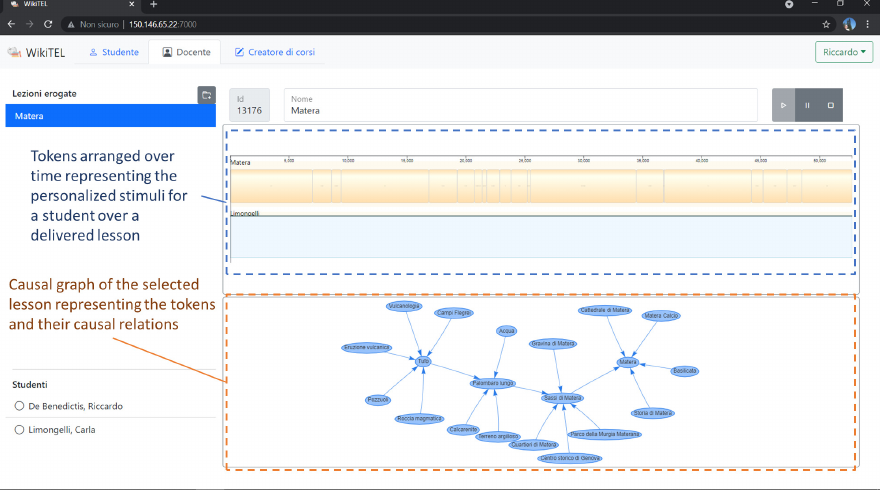
Figure 8. Planning and executing a personalized